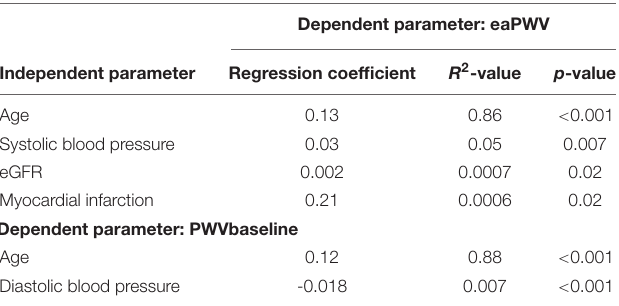
TABLE 3 | Significant influence parameters on estimated aortic pulse wave velocity (eaPWV) and PWVbaseline in multiple regression analysis.